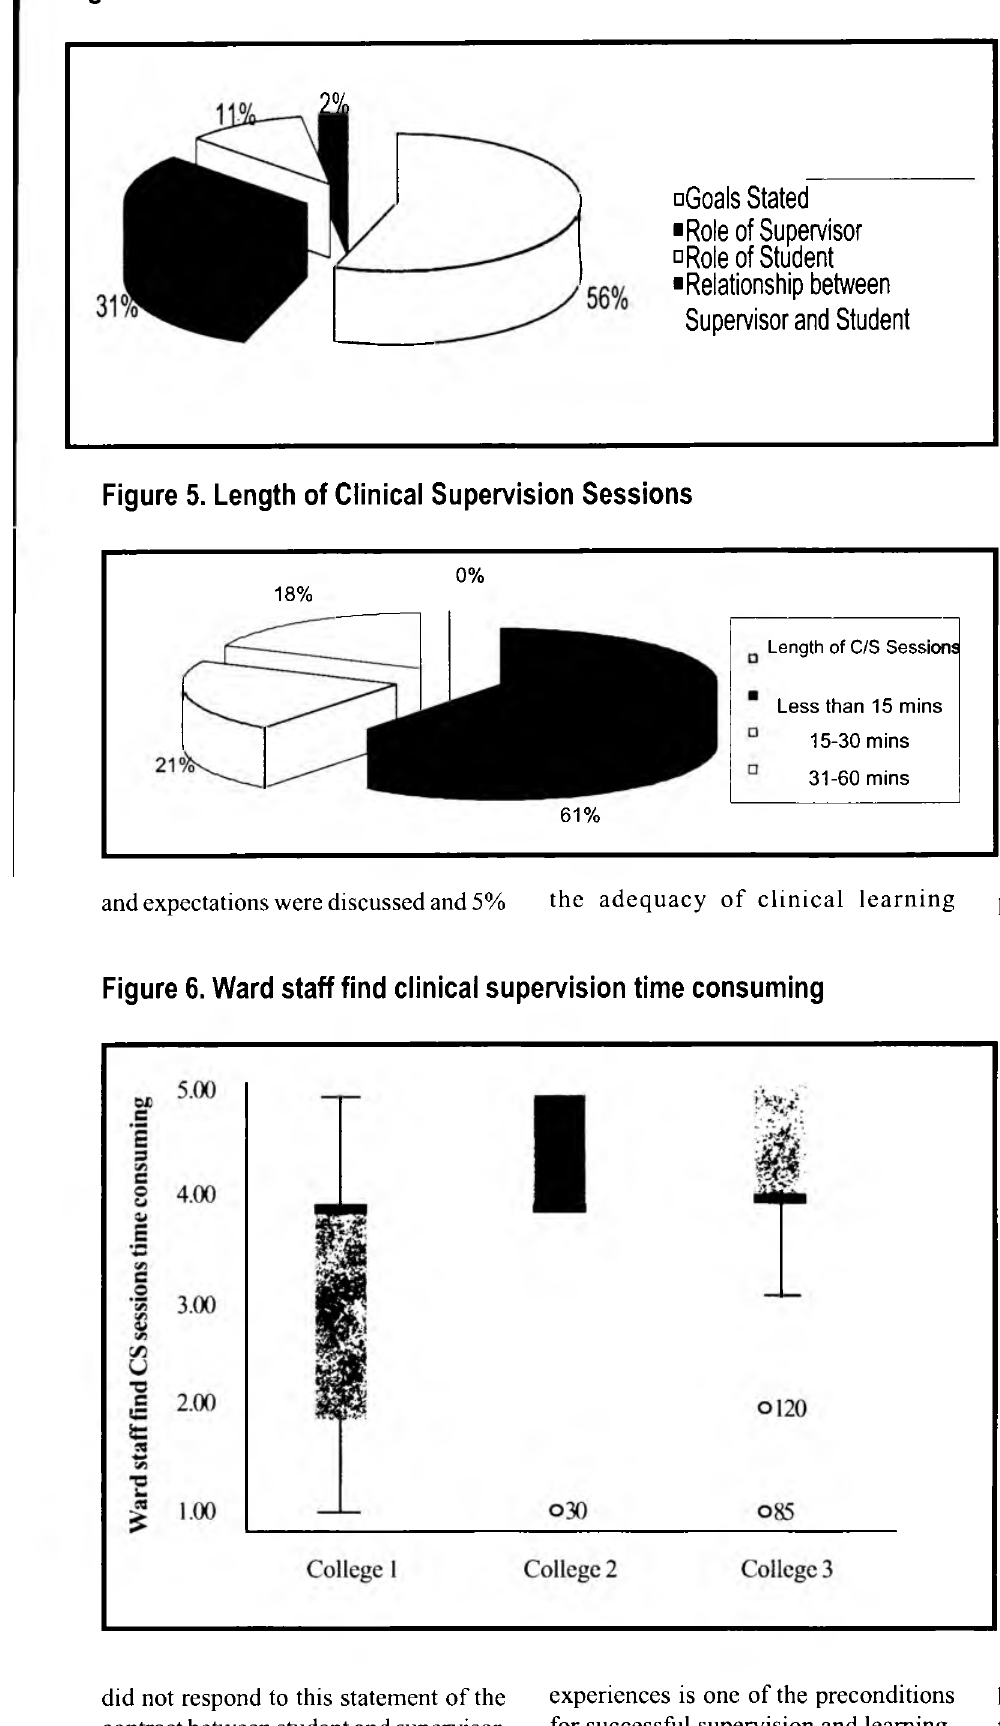
Figure 4: Contents of a Contract